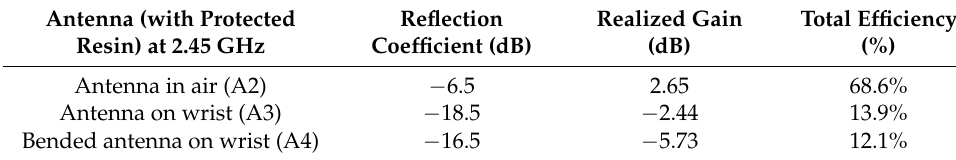
Figure 5. Radiation pattern of the antenna in 3D (directivity) and at φ =0 (realized gain): ( a ) A2 placed in air; ( b ) A3 placed on human body; ( c ) A4 bent on human’s wrist. The simulated gain and radiation efficiency are presented in Table 5. Table 5. Simulated performance of the proposed